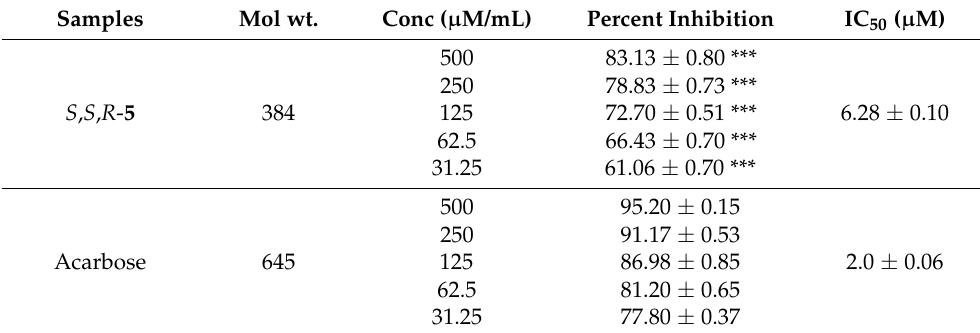
Table 2. Alpha-glucosidase inhibitory results of S , S , R - 5 .